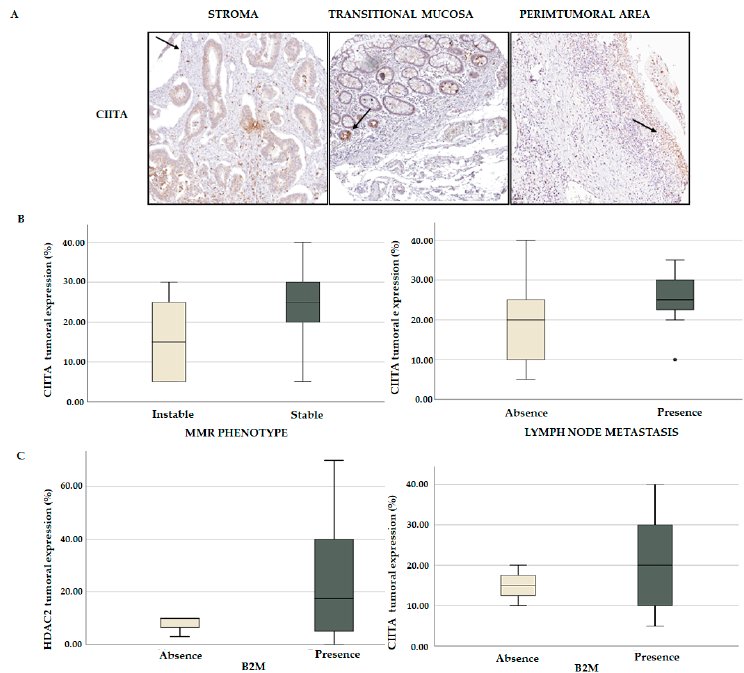
Figure 11. Immune regulatory players associated with HDAC2 expression. ( A ) IHC showing CIITA localization in stroma, transitional mucosa, and peritumoral area (black arrows). ( B ) CIITA tumoral expression in mismatch repair (MRR) phenotype ( p = 0.024) and metastatic lymph nodes ( p = 0.036). ( C ) Correlation between HDAC2 and B2M expression ( p = 0.368); correlation between CIITA and B2M ( p = 0.321).